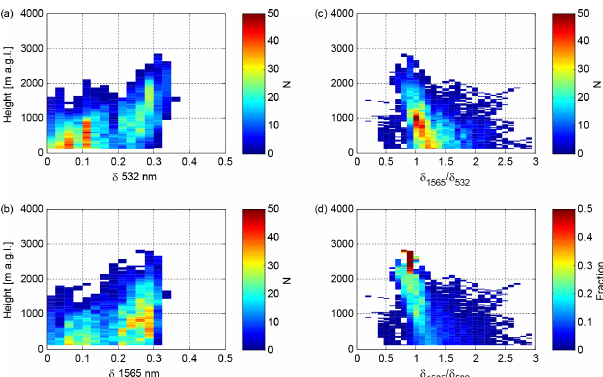
Figure 16. 2D histograms of the particle linear depolarization ratio and height at Limassol using 30m vertical resolution smoothed by a 300m running mean. Only data for σ δ < 0 . 01 (at the 1565nm wave- length) are included. (a) Depolarization ratio at 532nm. (b) Depo- larization ratio at 1565nm. (c) Ratio of depolarization ratios at 1565 and 532nm. (d) Same as panel (c) but scaled with number of obser- vations at each height.